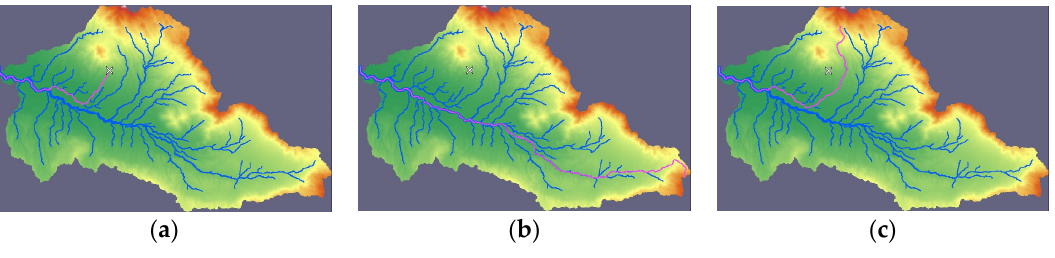
Figure 6. ( a ) Route Downstream. ( b ) Main Stream. ( c ) Nearest Stream.